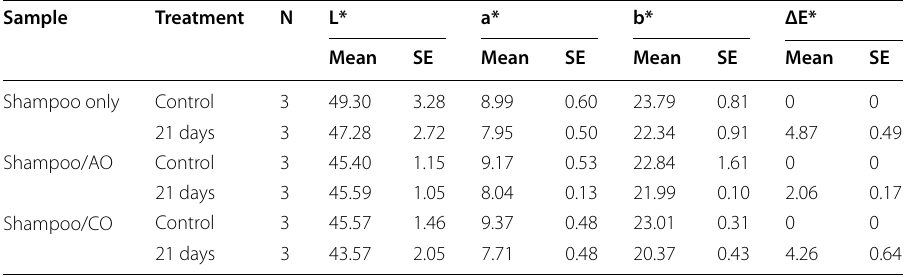
Table 8 Color values of bleached hair shampooed with or without the treatment of hair conditioner containing Argan oil (AO) or Camellia oil (CO) Sample